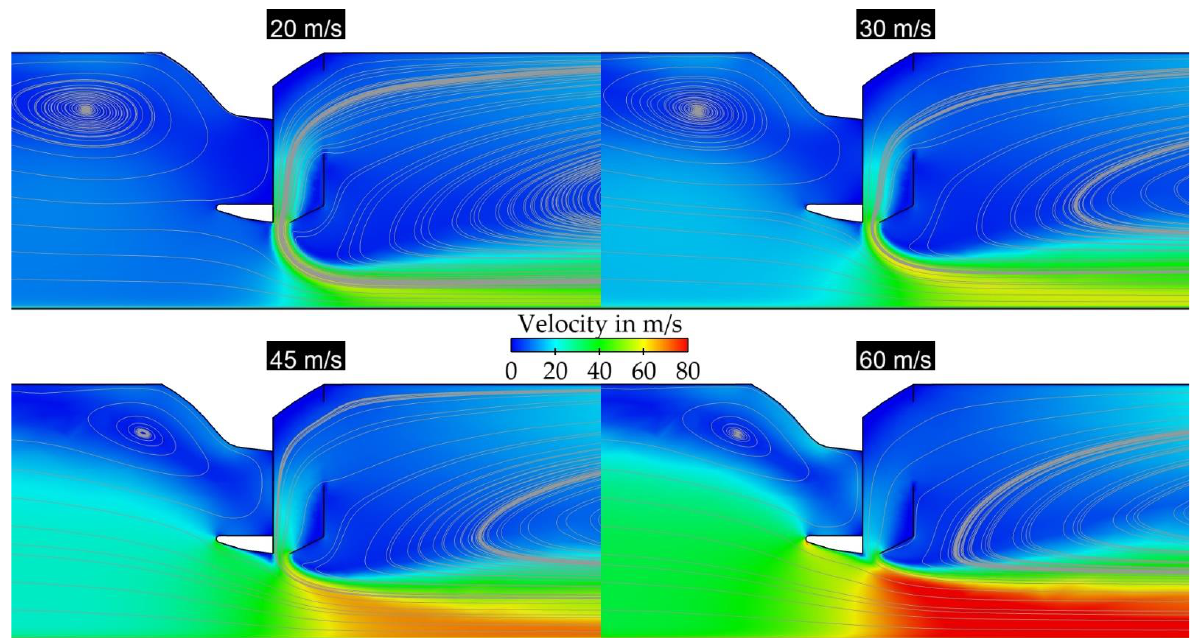
Figure 28. Velocity distribution and pathlines at front nozzles of FDDG for various inlet velocities. In Figure 29, pathlines from all curtains are shown, and their interaction within the low-pressure chamber is clearly visible. The flow pattern inside the low-pressure chamber will vary with increasing vehicle speed.